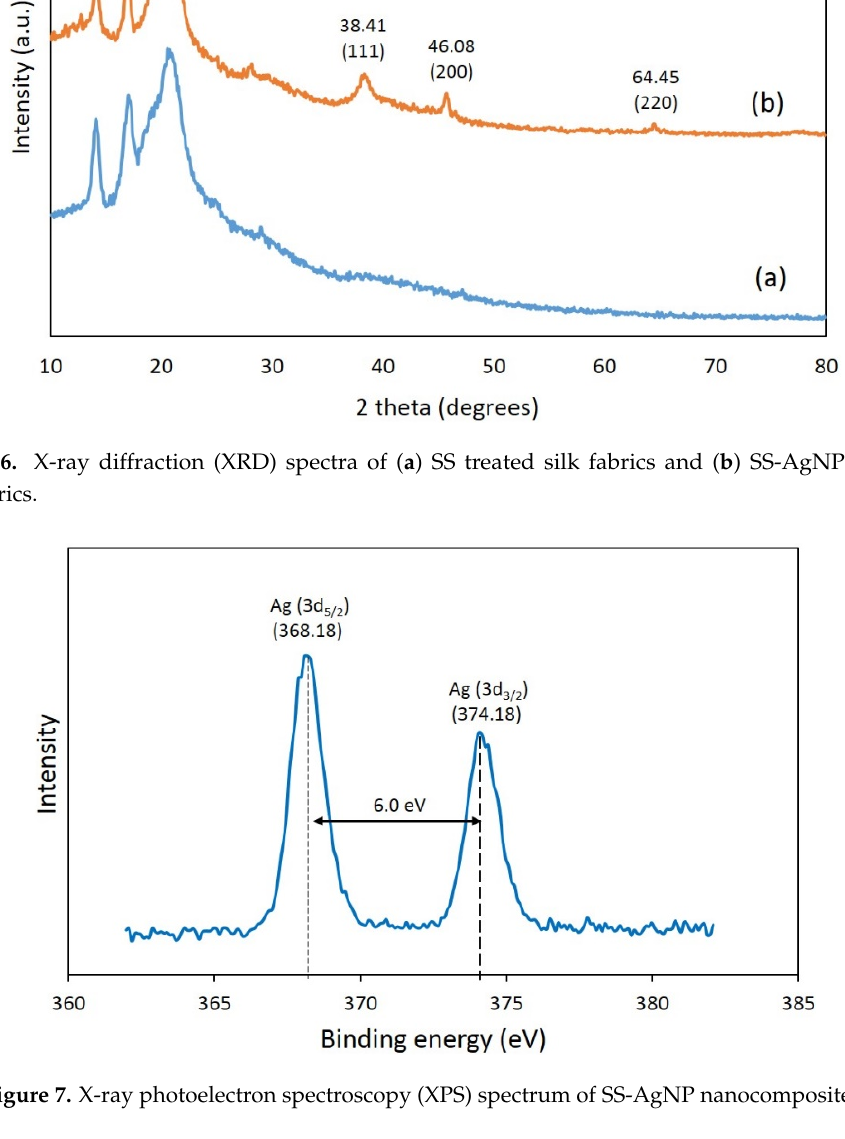
Table 4. Color coordinates of untreated and SS ‐ AgNP treated silk fabric.